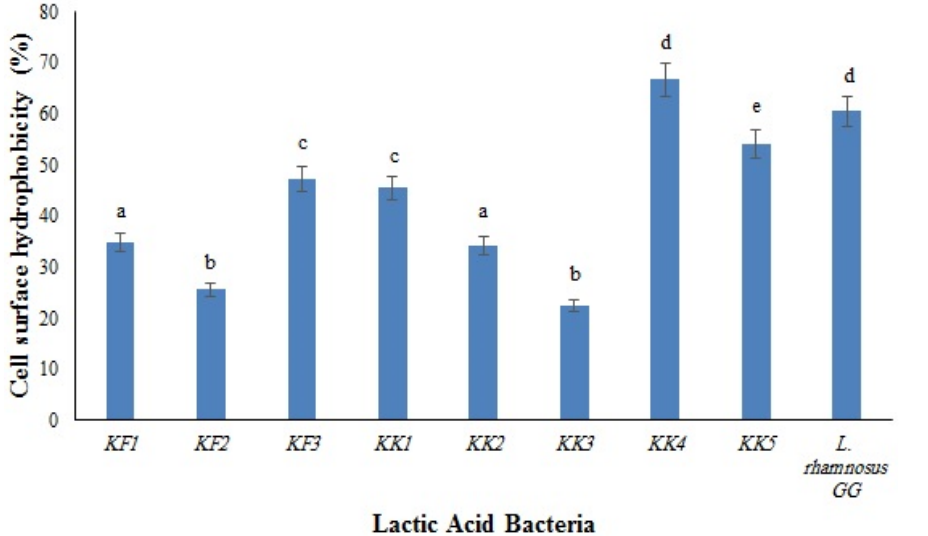
Figure 1. Cell surface hydrophobicity of the LAB isolates compared to the control strain, L. rhamnosus GG. Different letters show significant differences ( p < 0.05).